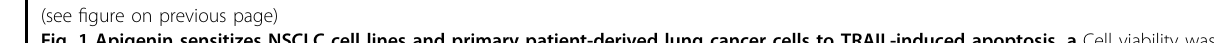
(Fig. S3d – g). Similarly, apigenin pretreatment of the highly metastatic advanced lung carcinoma cell line H1299 increased DR5 expression ~5-fold independently of TRAIL treatment (Fig. S4a, S4b) and signi fi cantly increased the ef fi cacy of TRAIL in reducing viability (Fig. S4c).